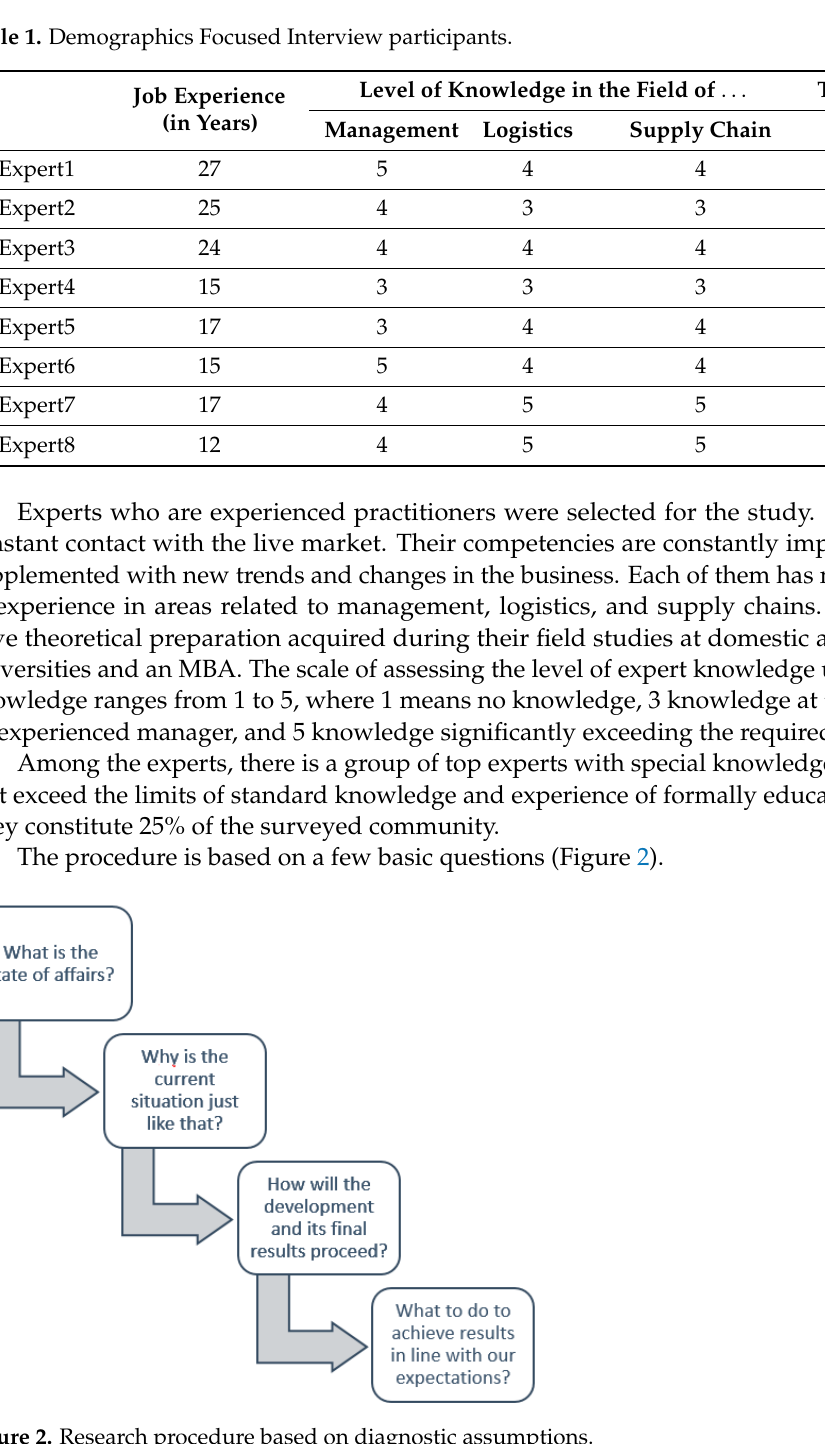
Figure 2. Research procedure based on diagnostic assumptions.